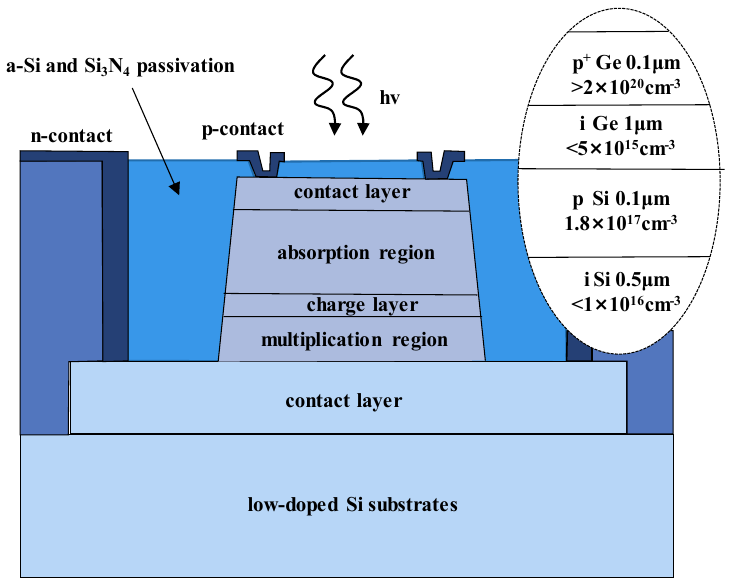
Figure 11. Schematic cross-section of Ge/Si SACM APD. Zhiwen Lu et al. [67] demonstrated the first relatively complete single photon counting results for Geiger-mode-operated Ge/Si APD. The thicknesses of the Ge absorption layer and Si multiplication layer are 1 µ m and 0.5 µ m, respectively (Figure 12). The charger layer is p-type doped (1.52 × 10 17 cm − 3 ) with a thickness of 0.1 µ m. Owing to the large lattice mismatch between the p-Si charger layer and the i-Ge absorption layer (4%), considerable traps were generated in the interface, leading to the higher dark current. To characterize the single photon detection efficiency (SPDE) and dark count rate (DCR), a 1.31 µ m pulsed laser was employed as the light source (the optical pulse width and pulse repetition rate are 50 ps and 100 kHz, respectively). Experimental results show that an SPDE of 14% and a DCR of 10 8 Hz were achieved. However, DCR is very high, and the device does not have enough time to recover its bias lever before other DCs are triggered, which will cause the underestimation of DCR at a certain bias.